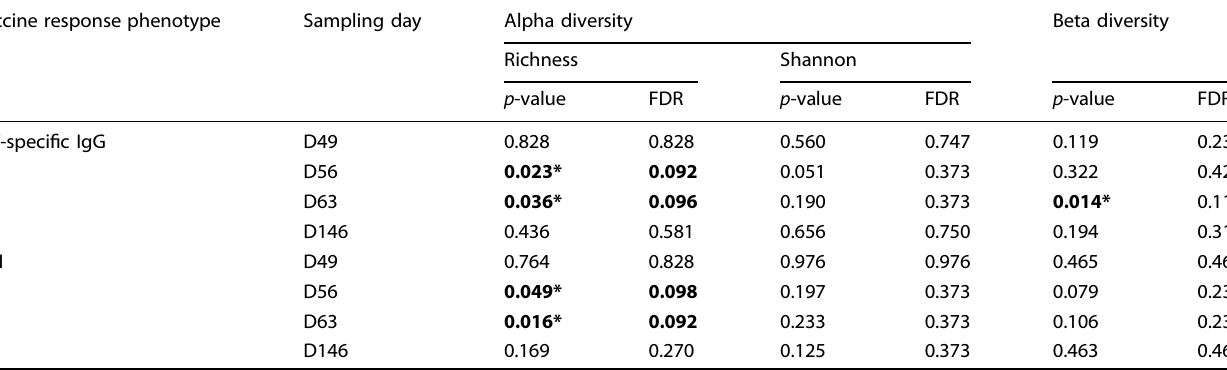
Table 2. Association between the alpha and beta diversity of the D28 fecal microbiota and the IAV vaccine response at D49, D56, D63, and D146. Vaccine response phenotype